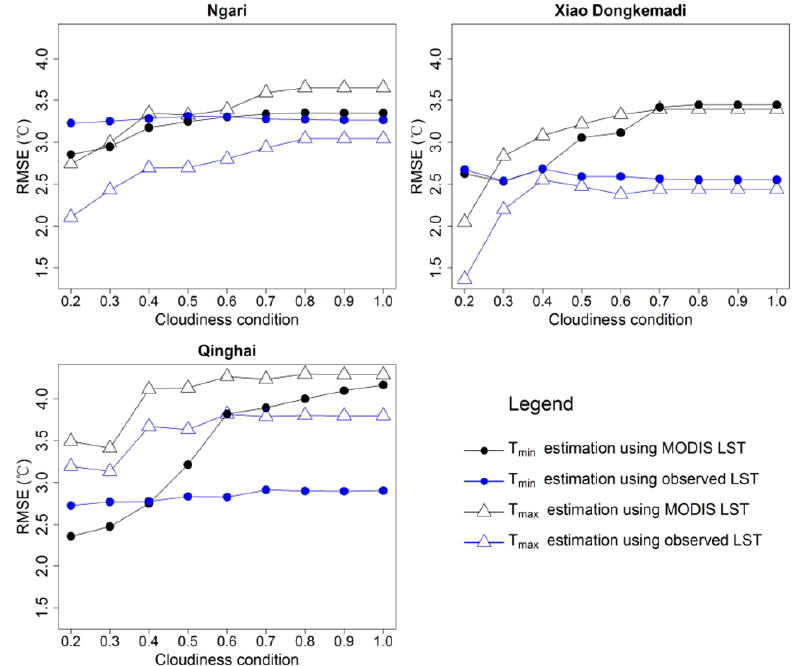
Figure 7. Accuracies (RMSE) of T max and T min estimations based on ground-measured or MODIS LST under different cloudiness conditions for the three AWSs. The “cloudiness condition” is the constraining condition of the daily averaged cloudiness index (CI). For example, a cloudiness condition of 0.2 denotes a constraining daily mean of CI ≤